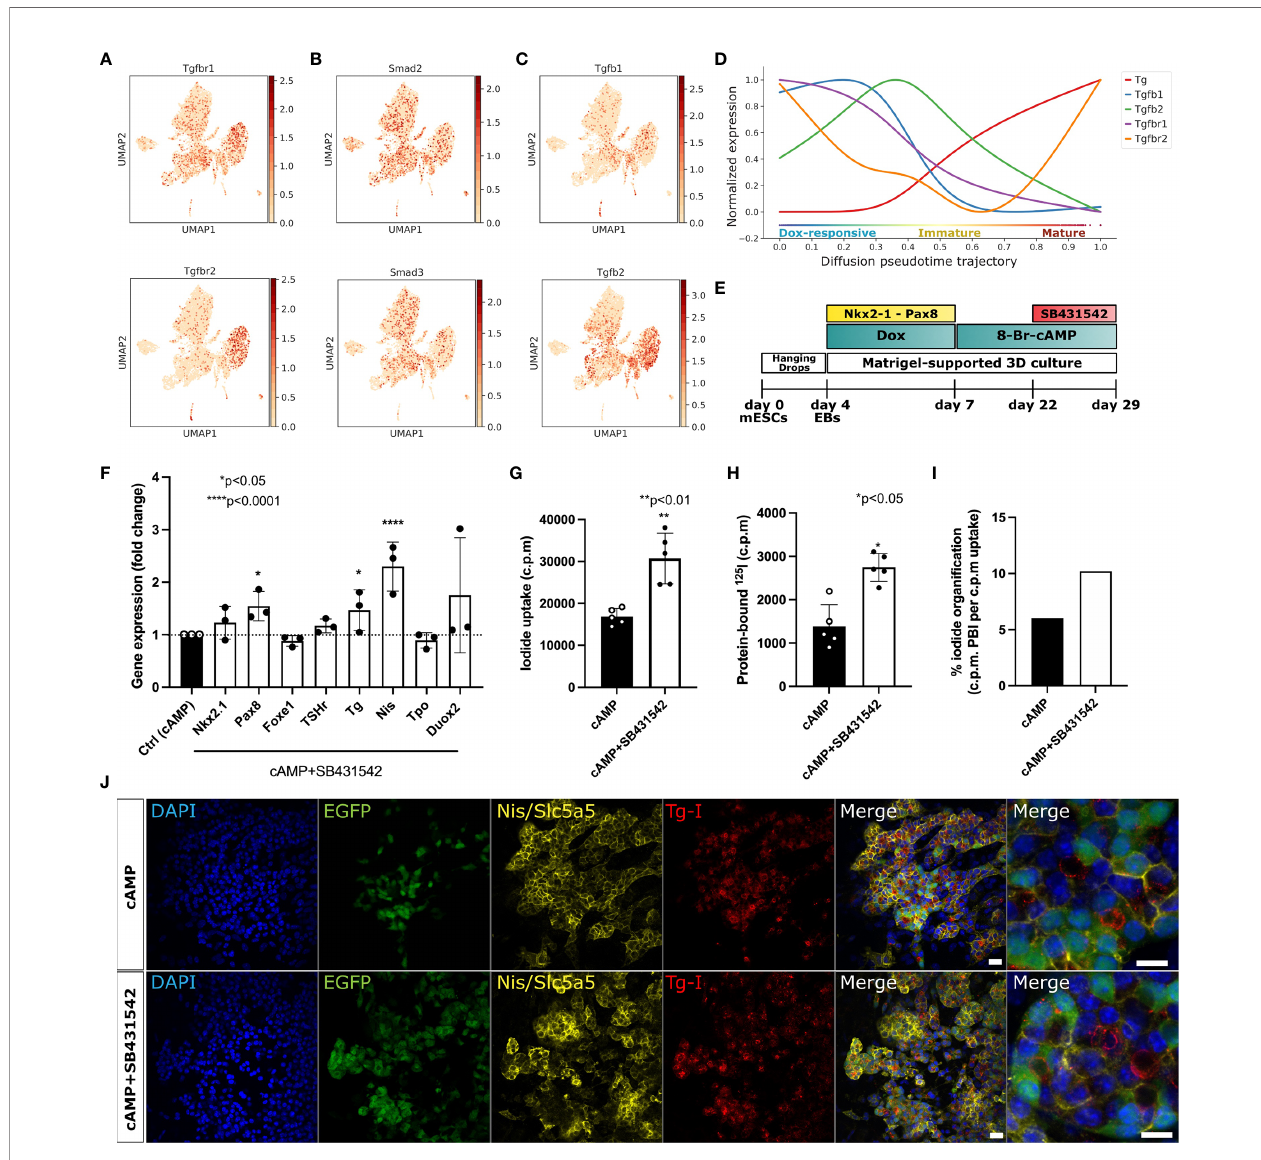
FIGURE 4 | Enhancement of maturation ef fi ciency by pharmacological inhibition of TGF-beta. (A) UMAPs demonstrate TGF-beta receptors ( Tgfbr1 and Tgfbr2 ), (B) activators ( Smad2 and Smad3 ) and (C) ligands ( Tgfb1 and Tgfb2 ) are expressed in mesoderm cells and in thyroid cluster. (D) Expression trends of TGF-beta receptors and ligands along pseudotime trajectory in thyroid cells. (E) Schematic representing the thyroid differentiation protocol to test the impact of TGF-beta inhibition on thyroid organoid maturation. TGF-beta inhibition was induced by co-treatment with cAMP+SB431542 from day 22 to day 29. (F) qPCR analysis demonstrates signi fi cant upregulation in Pax8 , Tg and Nis gene expression after 7 days of TGF-beta pathway inhibition. *p<0.05, ****p<0.001 by Mann-Whitney test (G – I) Functional organi fi cation assay con fi rms signi fi cant improvement in 125I uptake (G) and protein-bound 125I (H) under SB431542 treatment, which results in a higher percentage of cells with capacity of 125I organi fi cation (I) . **p< 0.01, *p<0.05 by Student ’ s t-test. (J) Immuno fl uorescence staining demonstrating that SB431542 treatment does not affect thyroid follicular organization evidenced by Nis speci fi c expression and Tg-I presence in the lumen space Scale bar: 20 µm and 10 µm